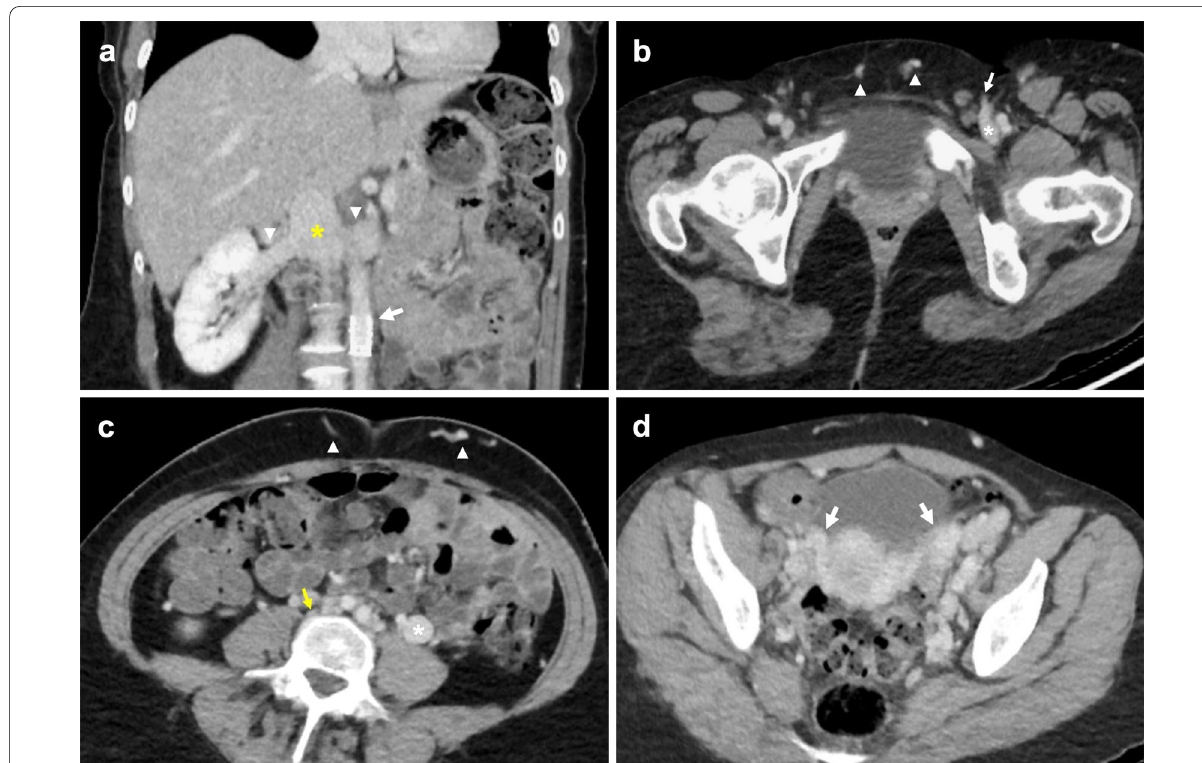
Fig. 8 Absent infrarenal IVC with multiple collateral pathways. Contrast-enhanced delayed venous phase on a CT abdomen and pelvis demonstrates prominent superficial abdominal, epigastric and gonadal veins draining the lower extremities. a Coronal CT image shows paired renal veins (arrowheads) draining into the caudal end of the IVC (asterisk). An aortic stent (arrow) is visualised inferior to the left renal vein. b Axial CT shows prominent external pudendal veins (arrowheads), and the left femoral vein (asterisk) receiving a distended superficial inferior epigastric vein (arrow). c Axial CT image with a distended left gonadal vein (asterisk). Small calibre unenhanced infrarenal IVC (arrow) is suggestive of chronic occlusion. Enhanced right inferior epigastric and abdominal wall veins are also visualised (arrowhead). d Axial CT demonstrates bilateral enlarged pelvic veins